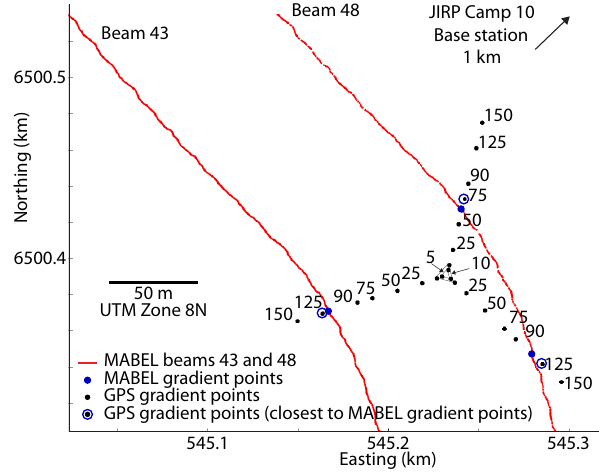
Figure 3. GPS survey on the Juneau Icefield. Ground tracks for MABEL beams 43 and 48, from the 31 July 2014 flight, are in- dicated (red lines). GPS survey points of the nodes of concentric, equilateral triangles, with side lengths of 5, 10, 25, 50, 75, 90, 125, and 150m, are indicated (black points). Also indicated are the in- tersections of the MABEL flight lines with the GPS survey grid (blue solid points), which were used to calculate MABEL surface gradients ( δz/δx and δz/δy ). The GPS sites that are the closest to the MABEL gradient points are also indicated (blue open circles). The overall slope, based on the MABEL elevations at the points of intersections with the GPS survey grid (blue solid points), is ap- proximately 0.5 ◦